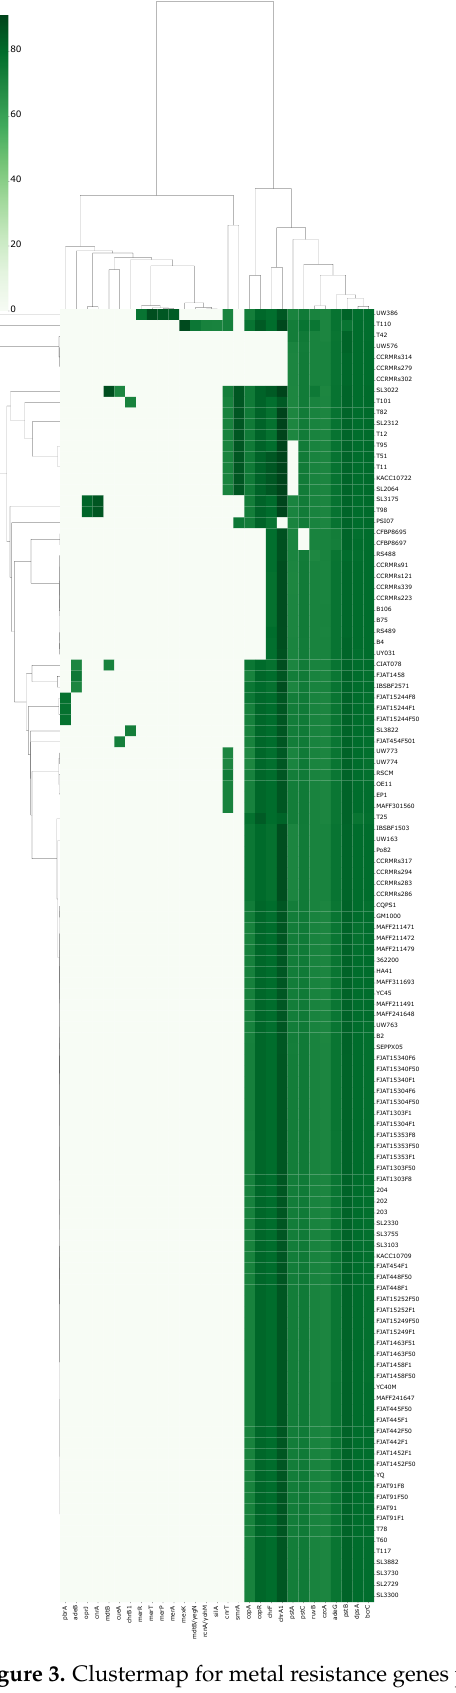
Figure 3. Clustermap for metal resistance genes presence and similarity against BacMet